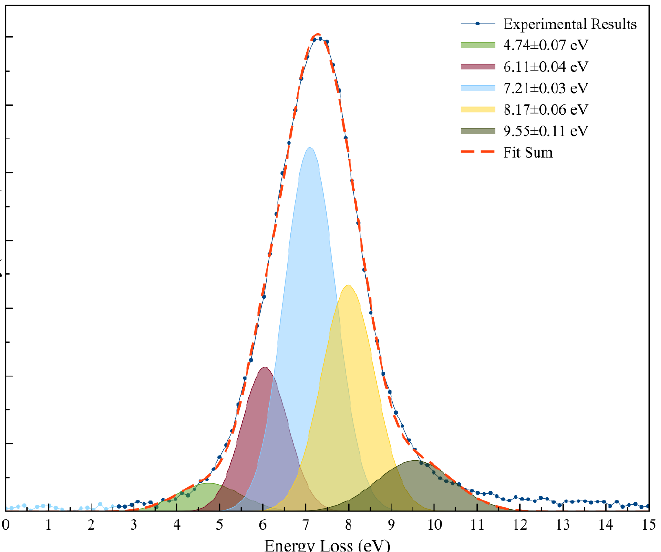
Figure 4. Post-collision potassium cation (K + ) energy loss spectrum at 157 eV in the center-of-mass frame (205 eV in the lab frame) in the forward scattering direction ( θ ≈ 0°). The peaks’ uncertainty result from the Gaussian fitting procedure. See text for details.